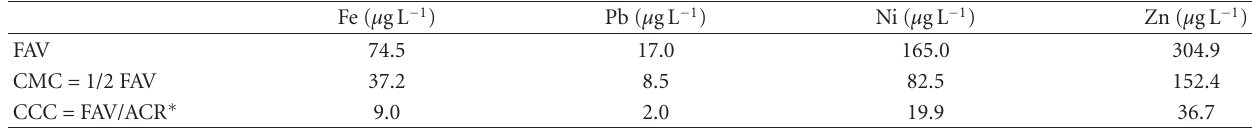
Table 2: FAV and CMC value for Fe, Pb, Ni, and